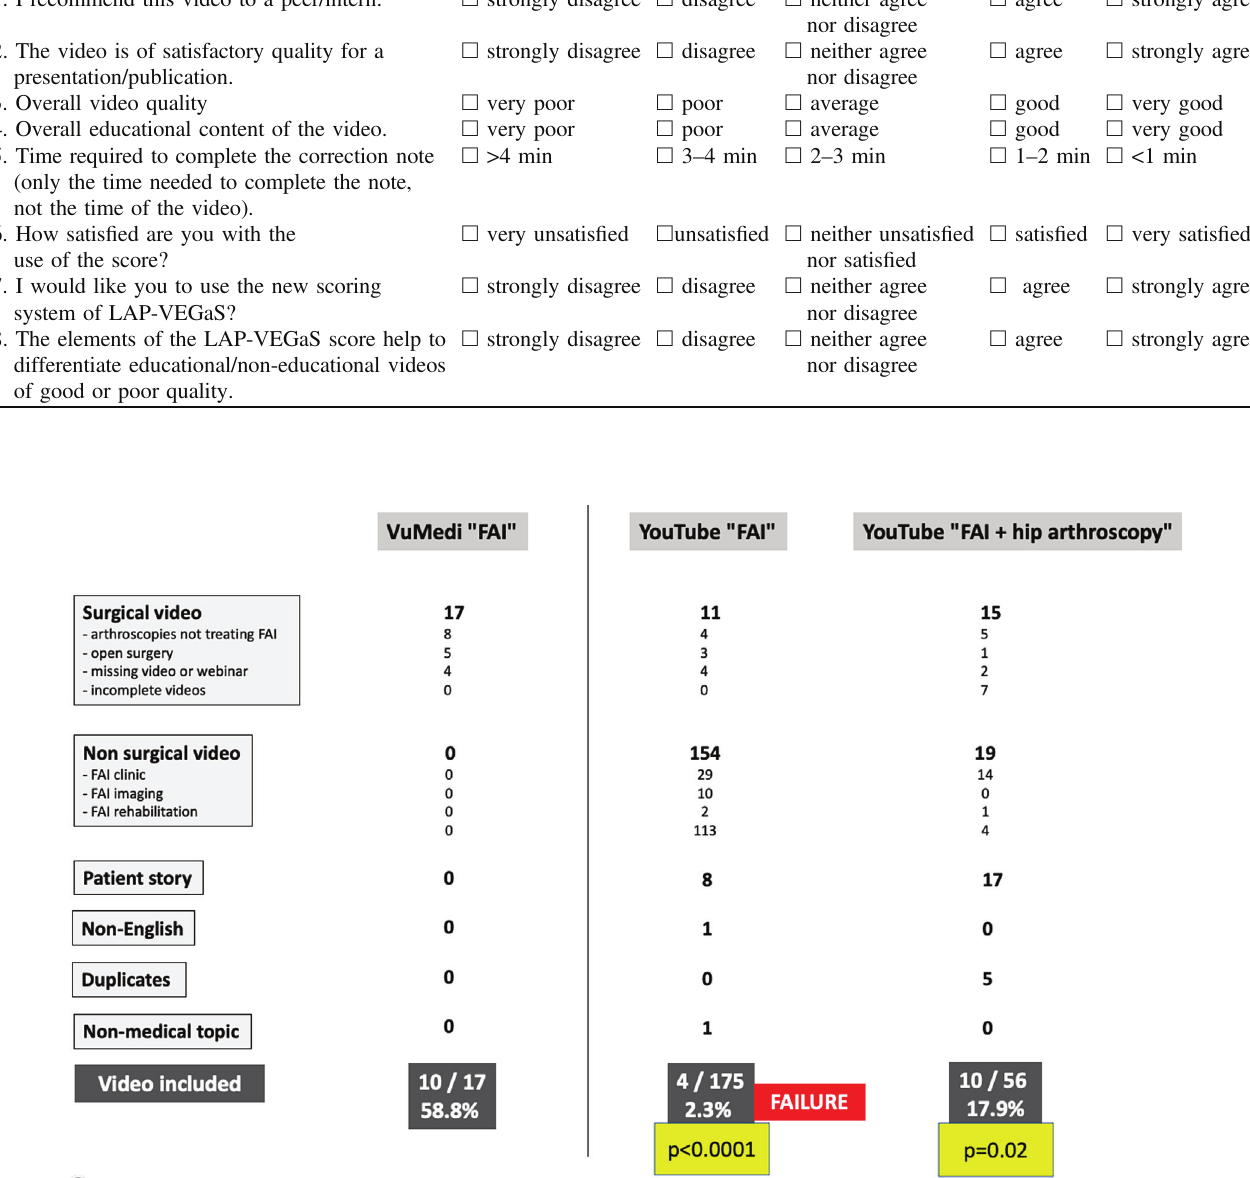
Figure 2. Video search fl